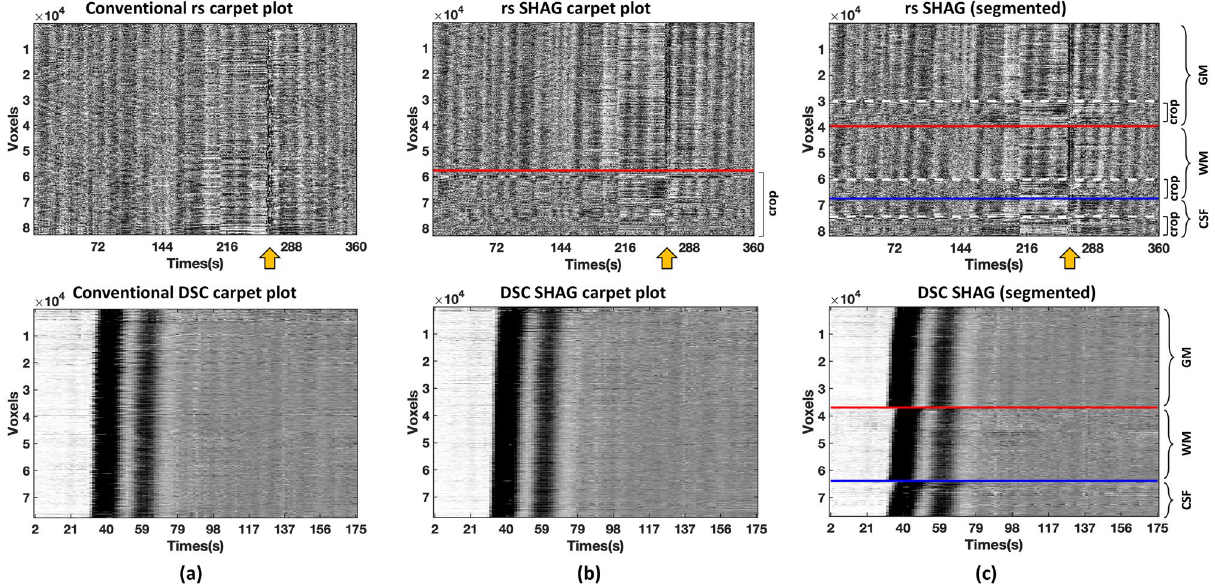
Figure 2. Comparison of conventional carpet plot and SHAG carpet plot for rs-fMRI (top row) and DSC-MRI (bottom row). Column ( a ) presents conventional carpet plots with no voxel ordering. Column ( b ) presents SHAG carpet plots with reordered voxels. For the rs SHAG carpet plot in the top row, voxels below the red line are those which would later be removed (cropped) from the carpet plot in order to perform edge detection. We note that voxels were similarly cropped from DSC SHAG carpet plots, however the percentage of voxels was so small that it could not be clearly labeled in this figure. Column ( c ) presents SHAG carpet plots segmented by